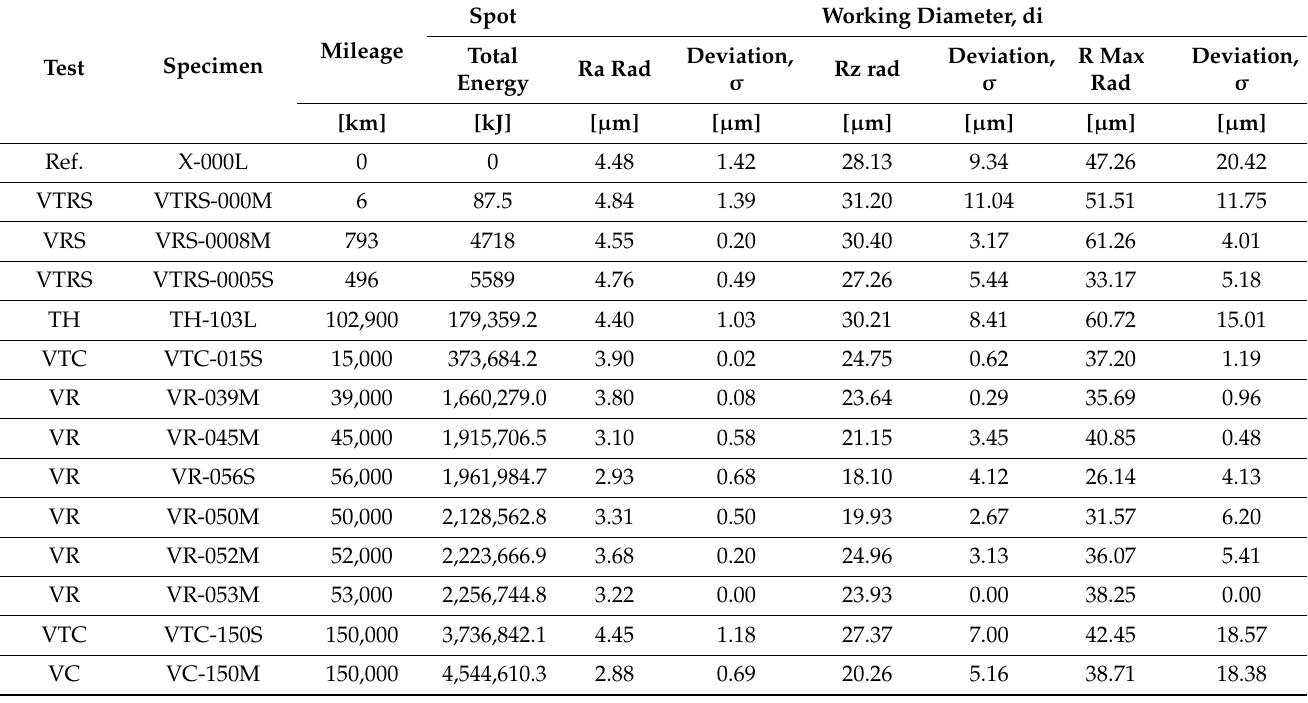
Table A4. Summary of the surface roughness values before (reference) and after different tests: outer diameter, radial direction.